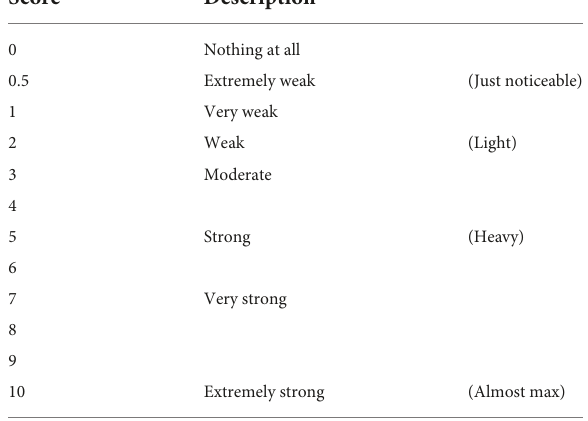
TABLE 1 Borg’s CR-10